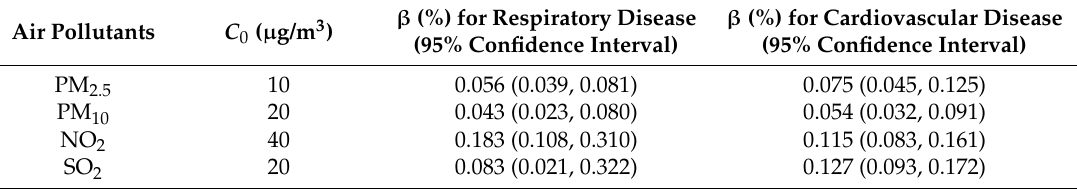
Table 2. Reference threshold and exposure–response coefficients of the multiple air pollutants. Air